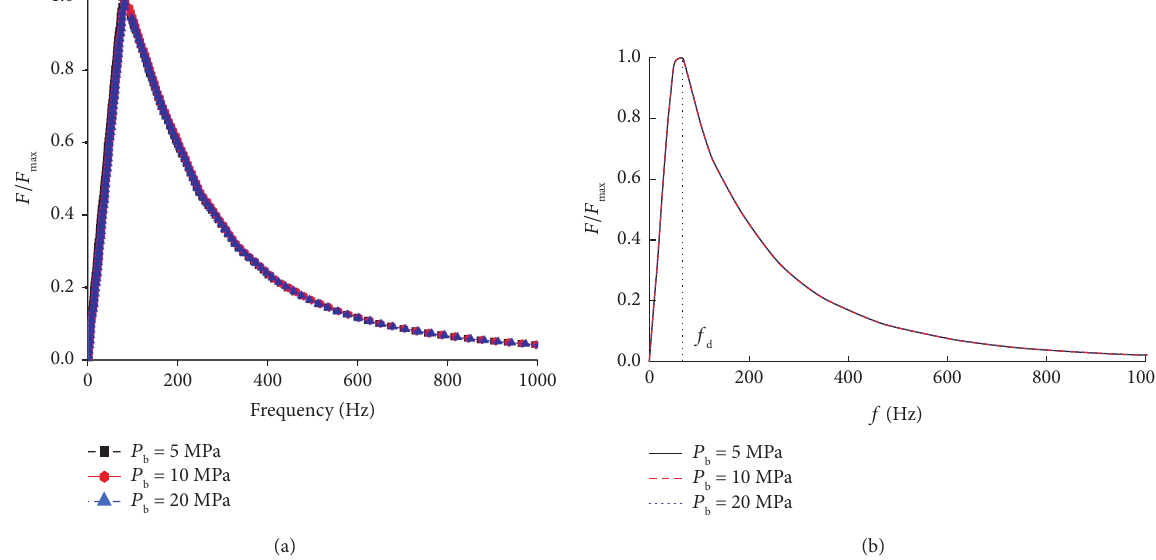
Figure 1: The effect of maximum blasthole pressure on frequency content: (a) this study’s results; (b) the results by Yang et al. [25]. fd represents the dominant frequency.